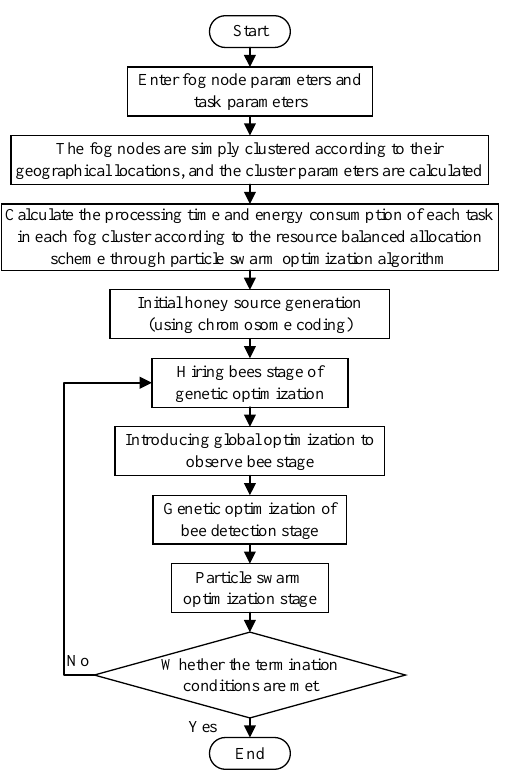
Figure 6. The detailed steps of the PGABC–PSO resource-scheduling algorithm. The overall algorithm steps are as follows: